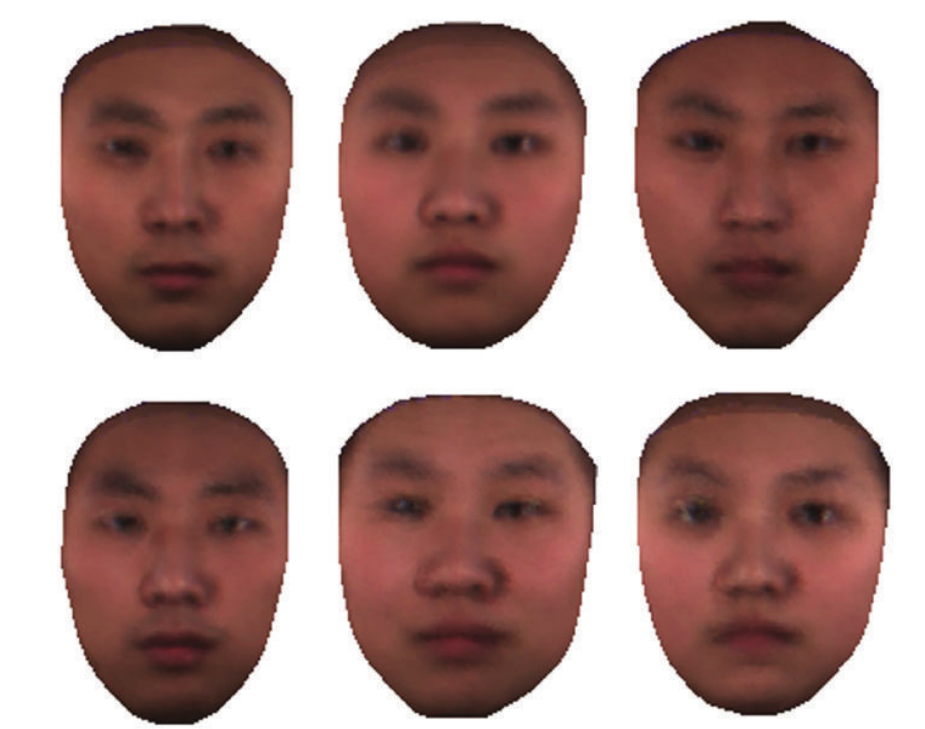
Figure 5: Six RFs of six clusters representing six different facial structure